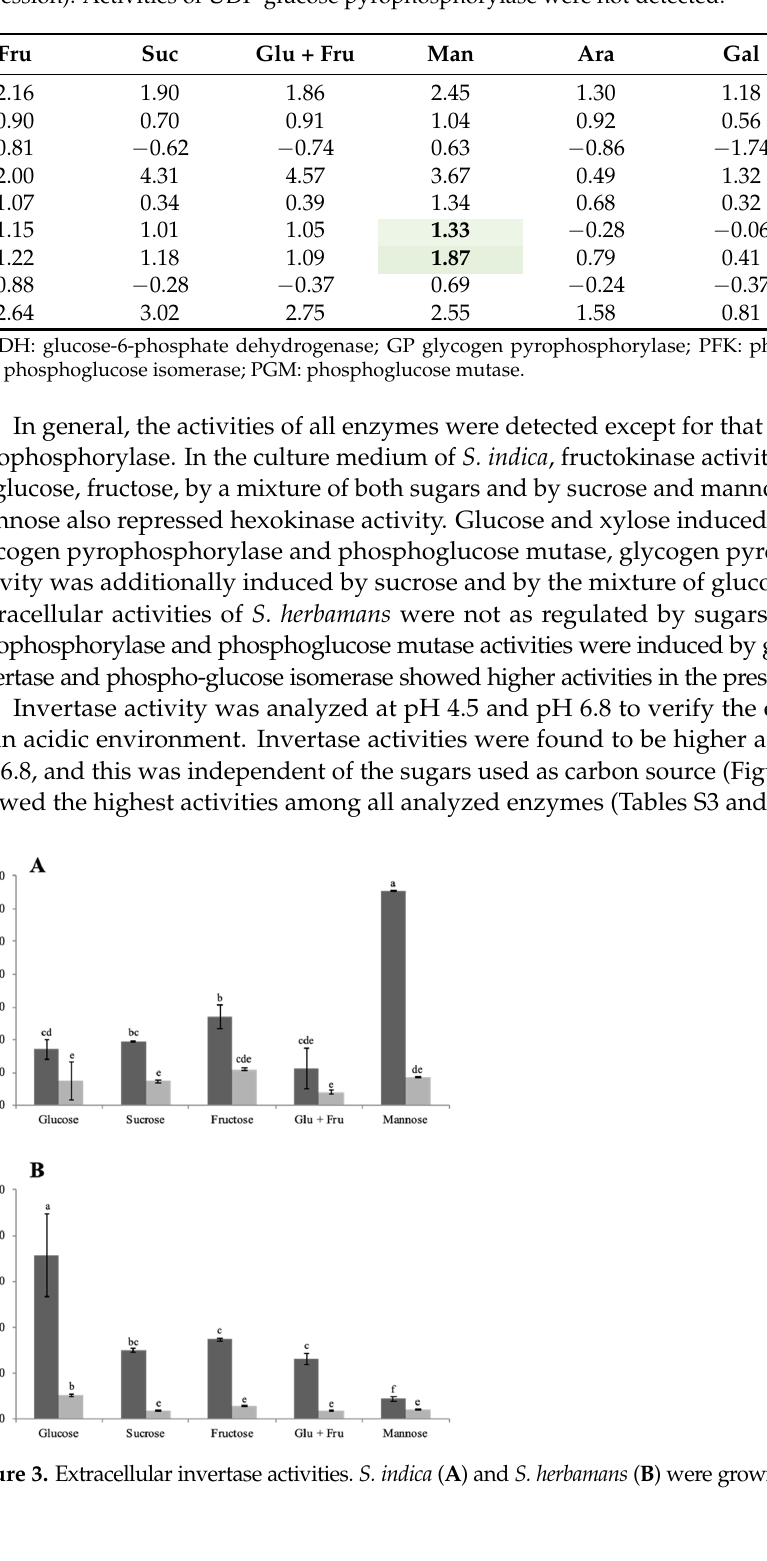
Table 5. Sugar regulation of extracellular enzyme activities of S. herbamans 5 days cultivated in the presence of glucose (Glu), fructose (Fru), sucrose (Suc), an equimolar mix of glucose and fructose (Glu + Fru), mannose (Man) or without sugar. The table shows the M-values (log2 of ratios of values obtained from sugar-treated cultures to values from cultures cultivated without sugar). Values higher than 1 (>2-fold induced) below − 1 (>2-fold repressed) and which are based on significant differences (Tukey HSD test; n = 6) are indicated in bold and color-coded (green: sugar induction; red: sugar repression). Activities of UDP-glucose pyrophosphorylase were not detected.